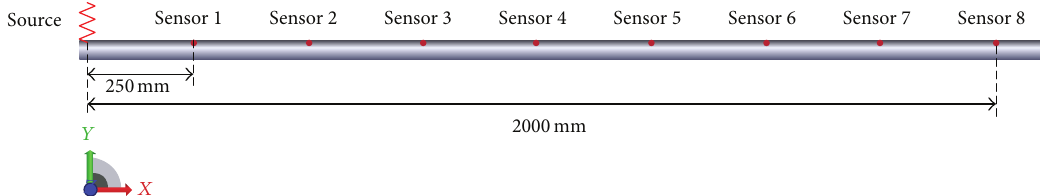
Figure 1: XLPE cable simulation model and the distribution of the sensors.